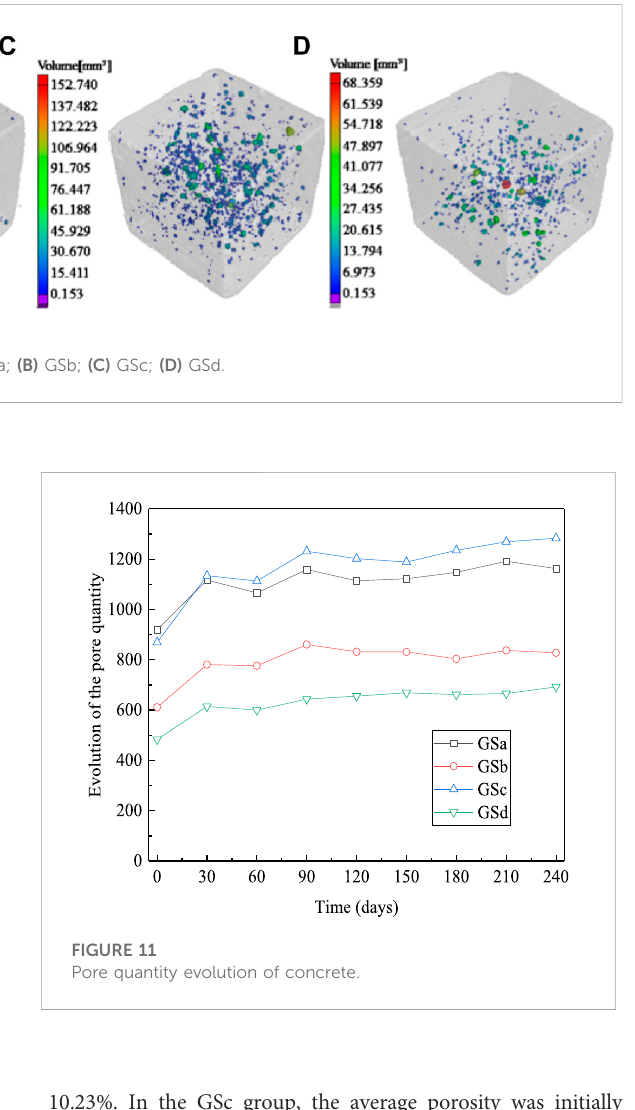
concrete test specimens in the different groups are displayed in Figure 9. The gray pro fi le in the graphs represents the overall morphology of concrete. Regions in different colors in the pro fi le represent pores of different volumes. The left tag